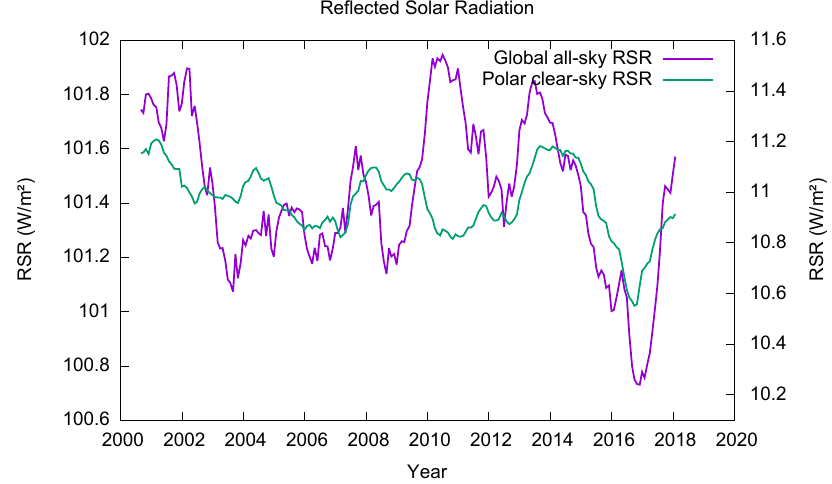
Figure 11. Purple curve, left scale: Global all-sky RSR. Green curve, right scale: Polar clear-sky RSR. The correlation between the global all-sky and the polar clear-sky RSR is 55%. This indicates that the influence of the polar SIE changes on the global all-sky RSR is